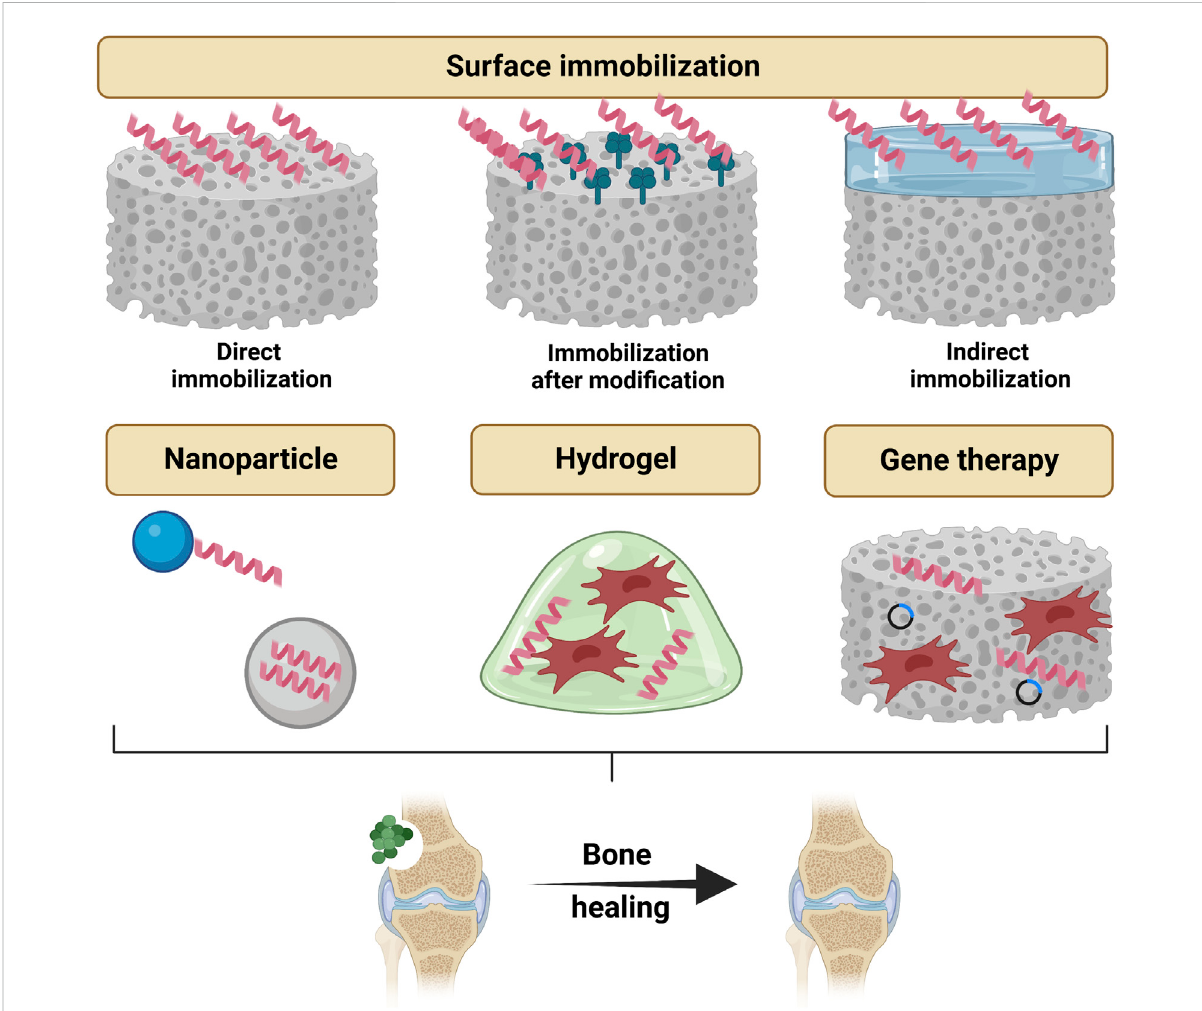
FIGURE 6 Topical strategies to administrate antimicrobial peptides for bone tissue engineering, which include delivery by surface immobilization (direct immobilization, immobilization after modi fi cation and indirect immobilization), delivery by nanoparticles, delivery by hydrogels and gene therapies. Created with